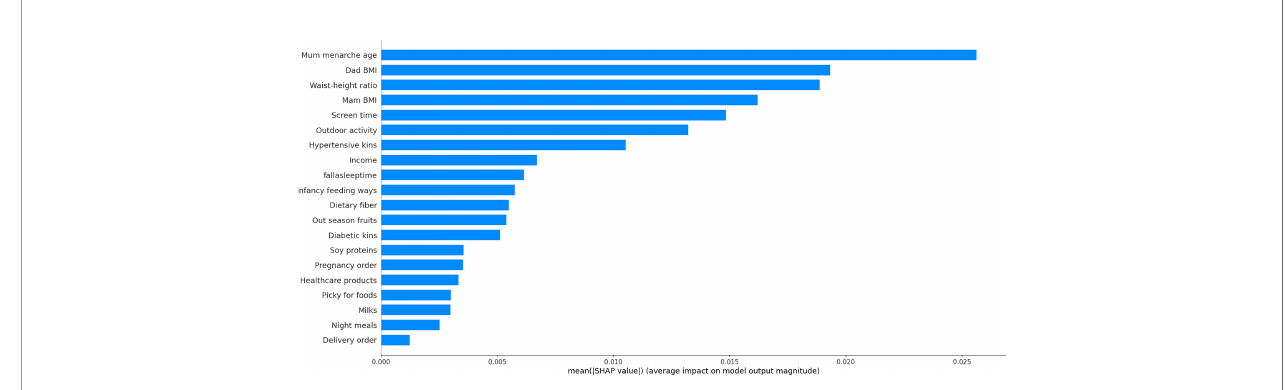
FIGURE 3 | Top 20 factors for predicting precocious puberty in a descending order of importance. BMI, body mass index.